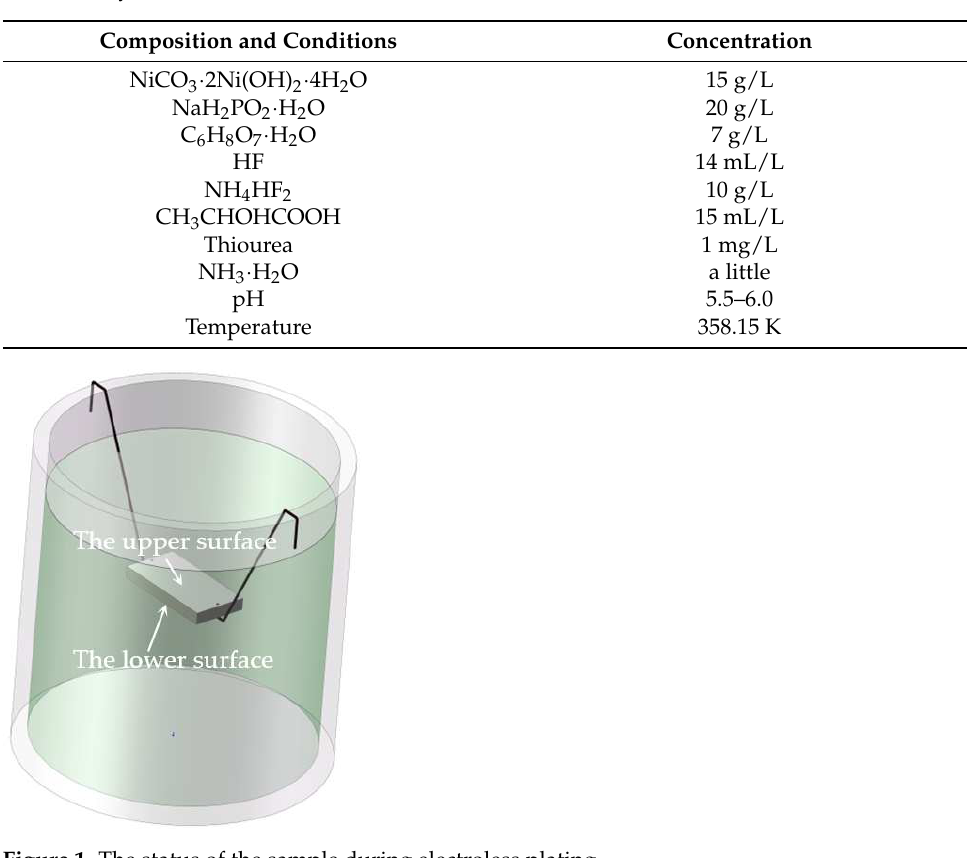
Figure 1. The status of the sample during electroless